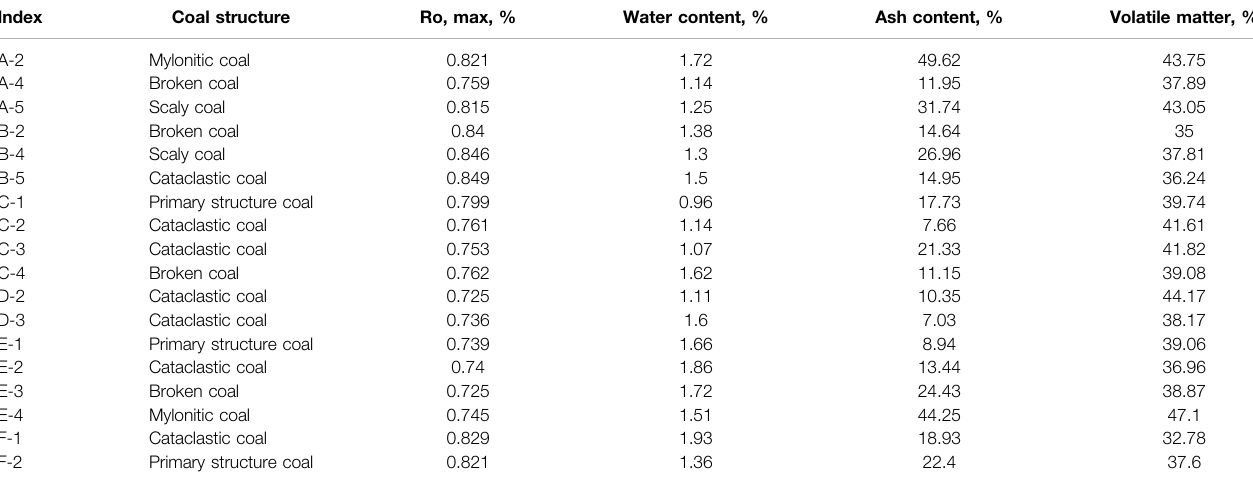
TABLE 1 | Vitrinite re fl ectance measurement and industrial analysis of